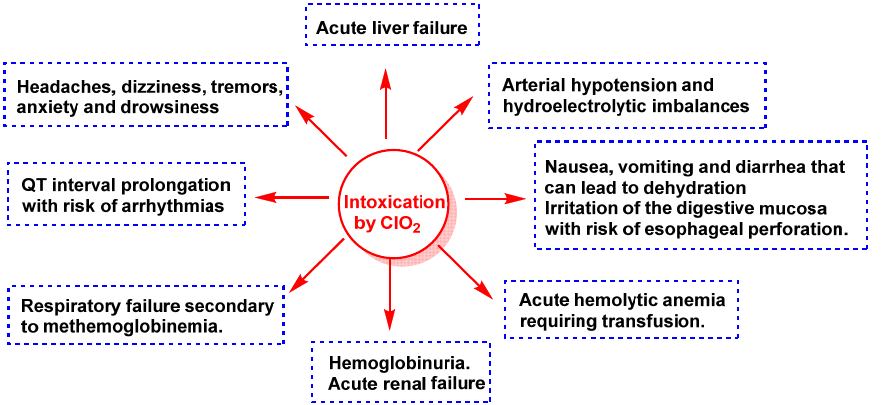
Figure 45. Serious adverse reactions after direct consumption of chlorine dioxide.